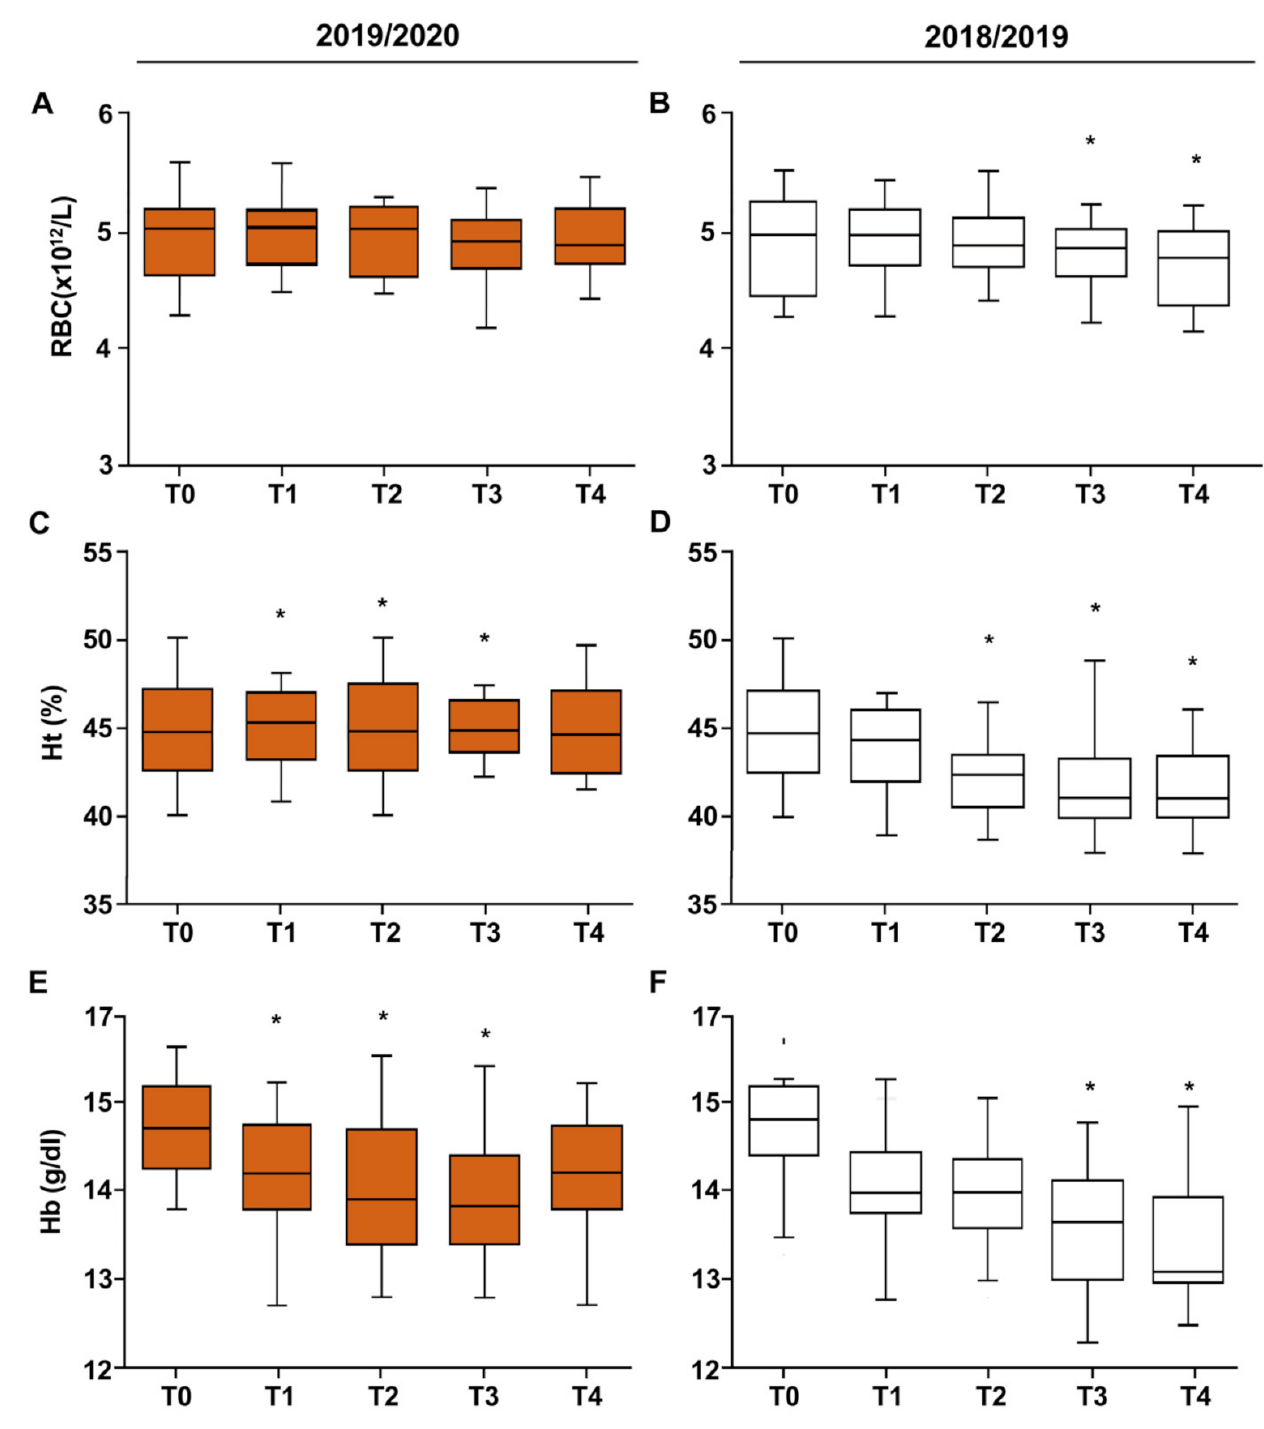
Figure 2. The effects of training on serum red blood cells ( A , B ), hematocrit (HT) percentage ( C , D ), and hemoglobin concentration ( E , F ) in football players during the 2018/2019 and 2019/2020 seasons. Box and whiskers representation of red blood cells, hemoglobin concentration, and hematocrit (HT) percentage evaluated five times (T0, T1, T2, T3, and T4) during the seasons. In this representation, the central box covers the middle 50% of the data values, between the upper and lower quartiles. The bars extend out to the extremes, while the central line is at the median. p -values were obtained by Student’s paired t -test between each timepoint and T0. * p <